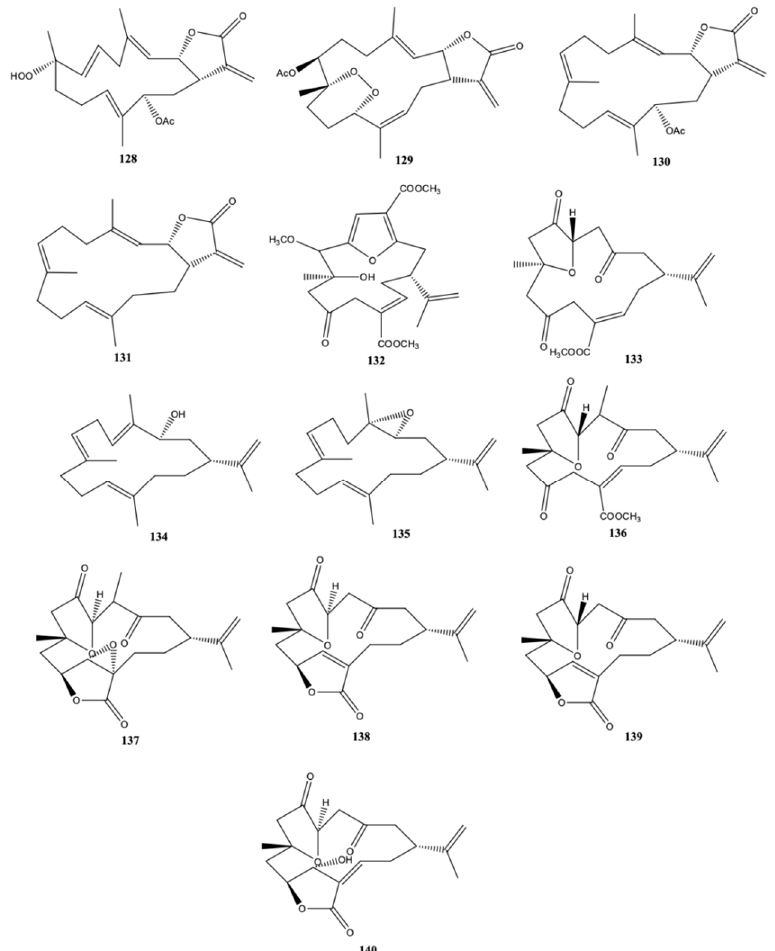
Figure 13. Cembranoid diterpene isolated from Sinularia sp. collected in Mantanani Island, Sabah and Yongxing Island, both in the South China Sea [42,43].